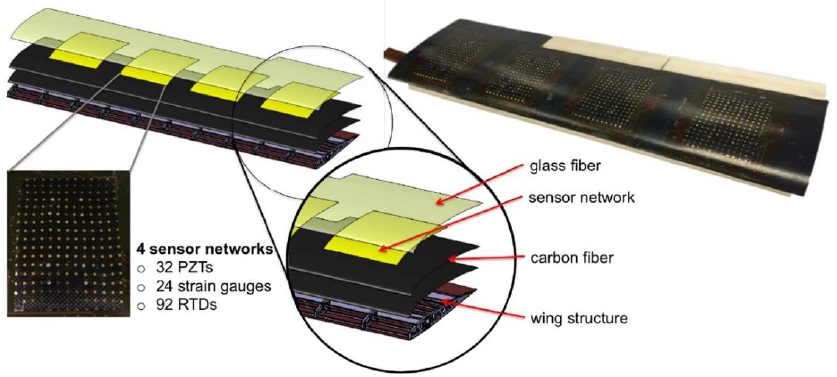
Figure 1. The self-sensing composite wing design [2].